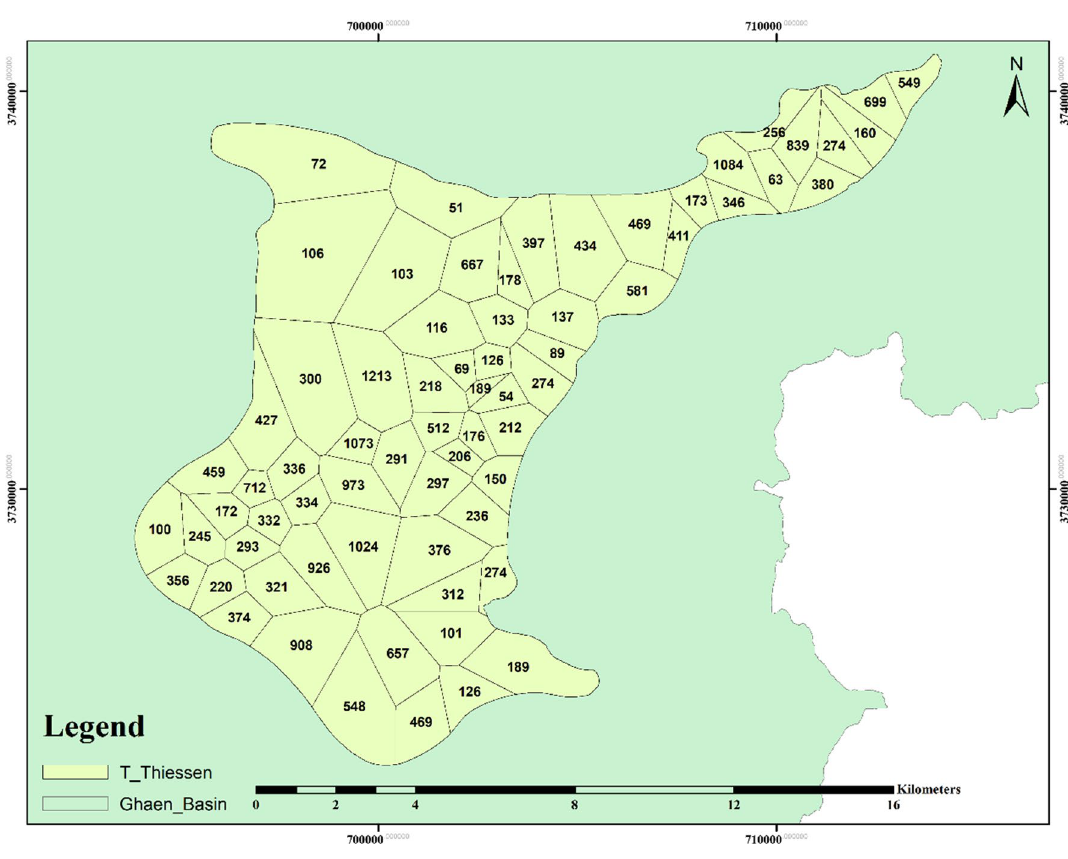
Fig. 3 Transmissivity thiessen in Ghaen